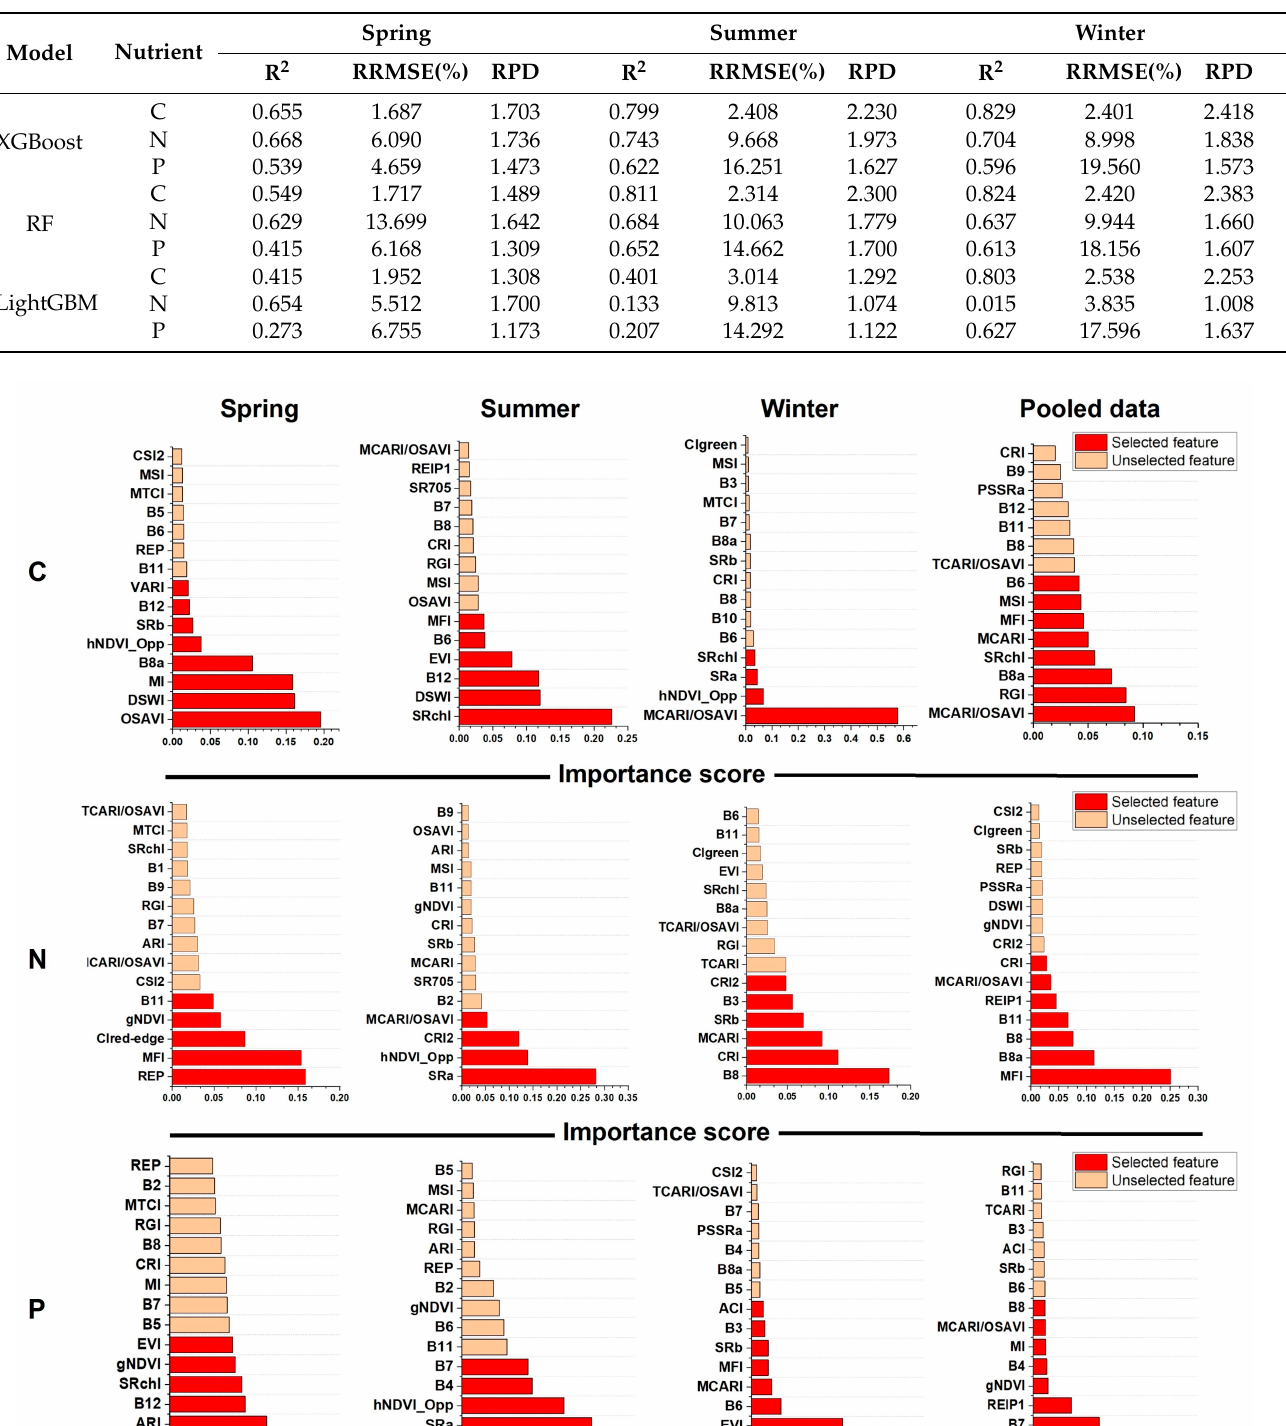
Table 8. Model performance in estimating leaf C, N, and P using the dataset of a single season.